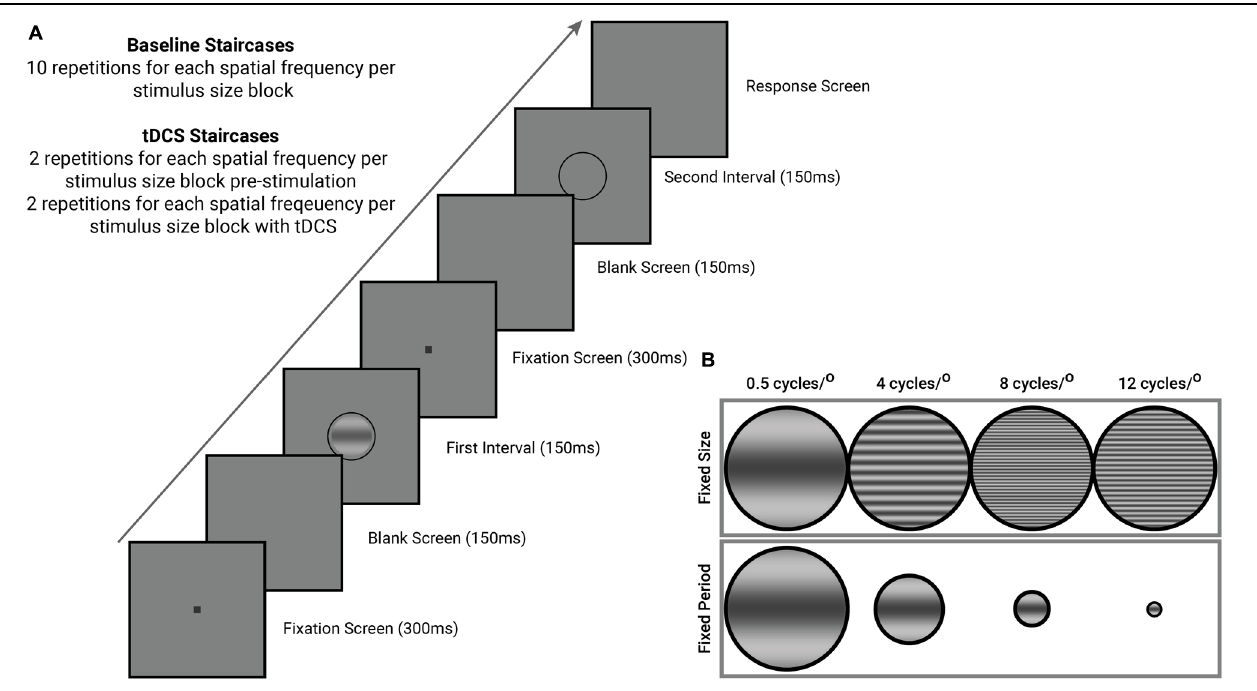
FIGURE 1 | General psychophysical procedures completed by all observers in this study. (A) Stimulus presentation sequence (see text for details). (B) Contrast sensitivity was measured for both stimuli of a fixed size and fixed period, at four different spatial frequencies (0.5, 4, 8, and 12 cycles/ ◦ ). Groups ( n = 10 per group) were split according to stimulus orientation (45 ◦ oblique, and horizontal). Stimuli in the fixed period condition do not represent the actual change in size of our stimuli during the staircase, and are a graphical representation of the different stimulus dimensions used in this study. Stimuli of a fixed size subtended 3 ◦ of visual angle while stimuli of a fixed period had a period of 1.5